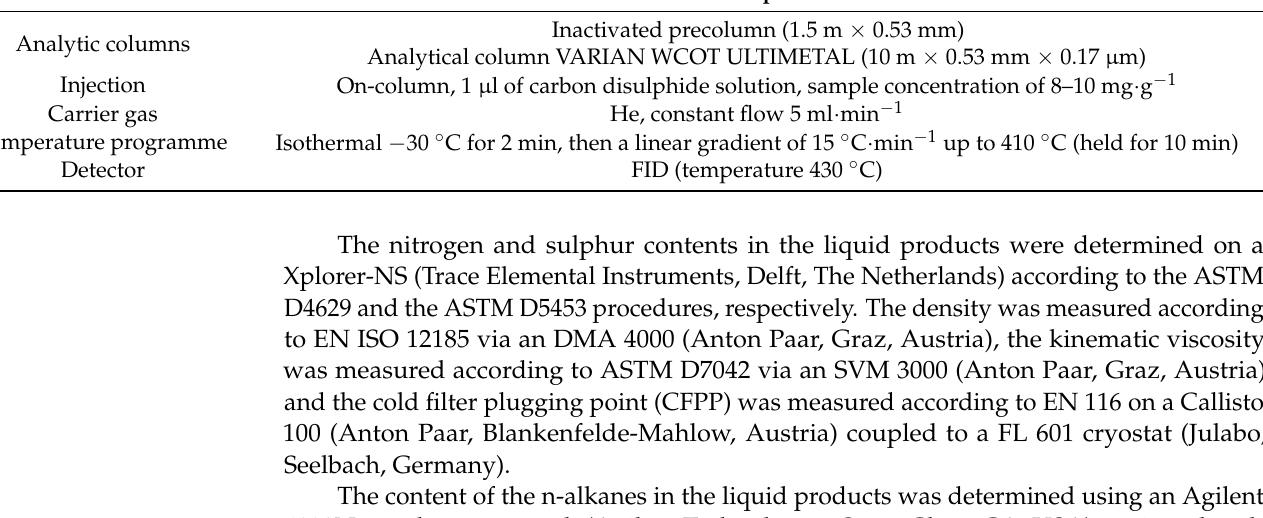
Table 15. The chromatographic conditions of the simulated distillation. Parameter